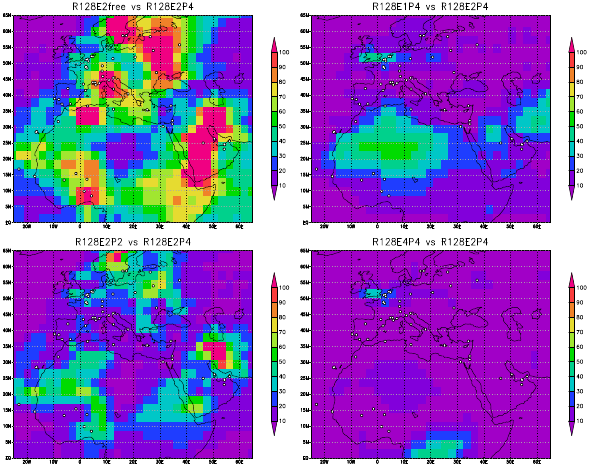
Fig.3. Time-averageddifferences[%]inAOT,for n reg =128 experiments. Theblack&whitedotsrepresentAERONETsites. Fig. 3. Time-averaged differences [%] in AOT, for n periments. The black & white dots represent AERONET sites.